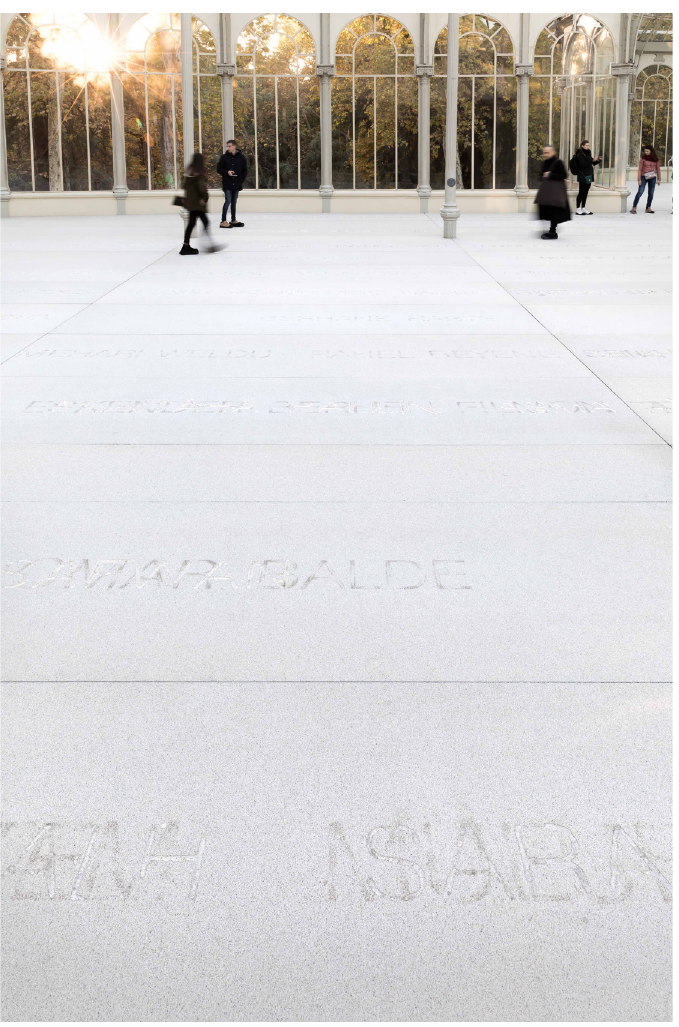
photographer Patrizia